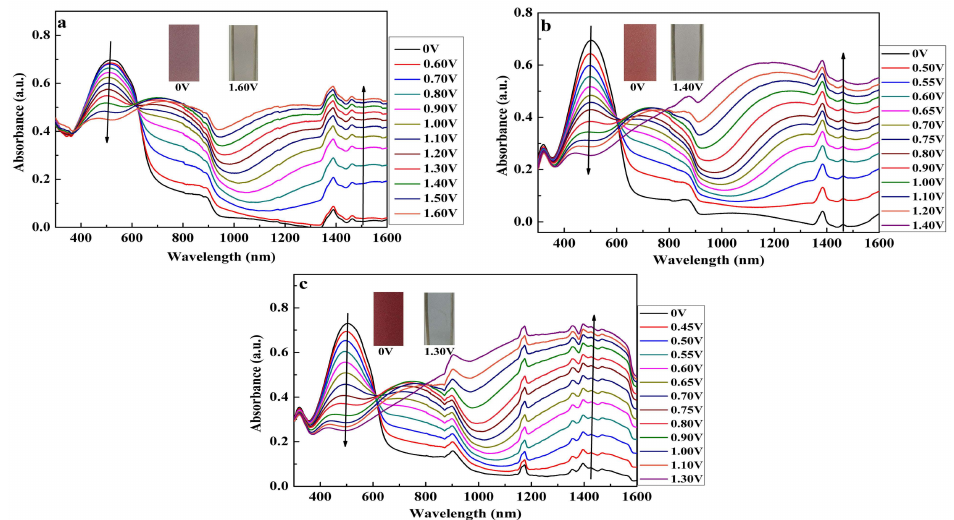
Figure 5. Spectroelectrochemical spectra of P1 ( a ); P2 ( b ); and P3 ( c ) and color change of film under different